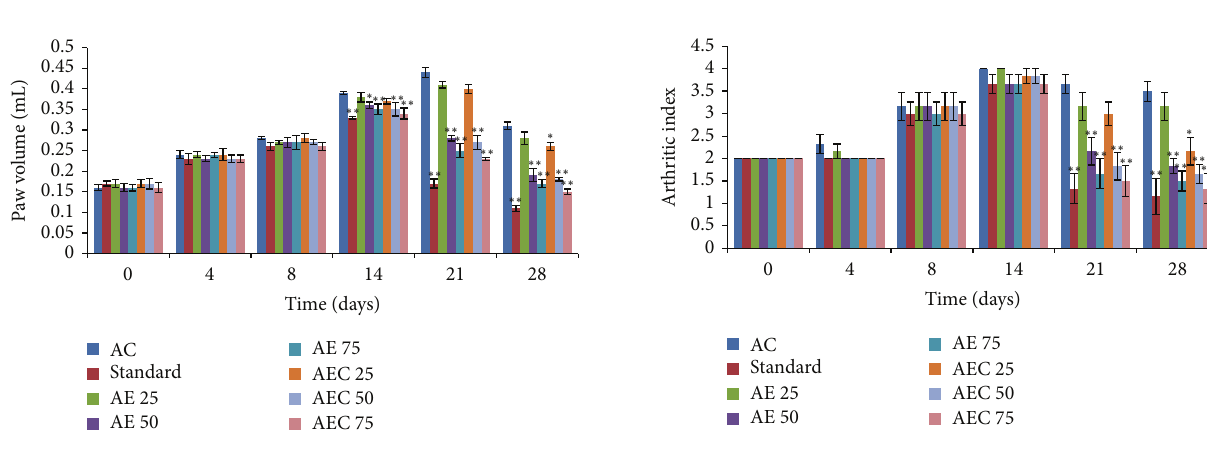
Figure 6: Effect of AE and AEC on arthritic index in Freund’s complete adjuvant induced arthritic rats. Results were presented as mean ± SEM ( 𝑛 = 6 ). The data was analysed using one-way analysis of variance (ANOVA) followed by Dunnett test. ∗ 𝑃 < 0.05 , ∗∗ 𝑃 < 0.01 when compared with arthritic control group. AC: arthritic control; Std. : Diclofenac sodium 10mg/kg p.o.; AE: aloe emodin (25, 50, and 75 mg/kg p.o.); AEC: carboxylic acid derivative of aloe emodin (25, 50, and 75 mg/kg